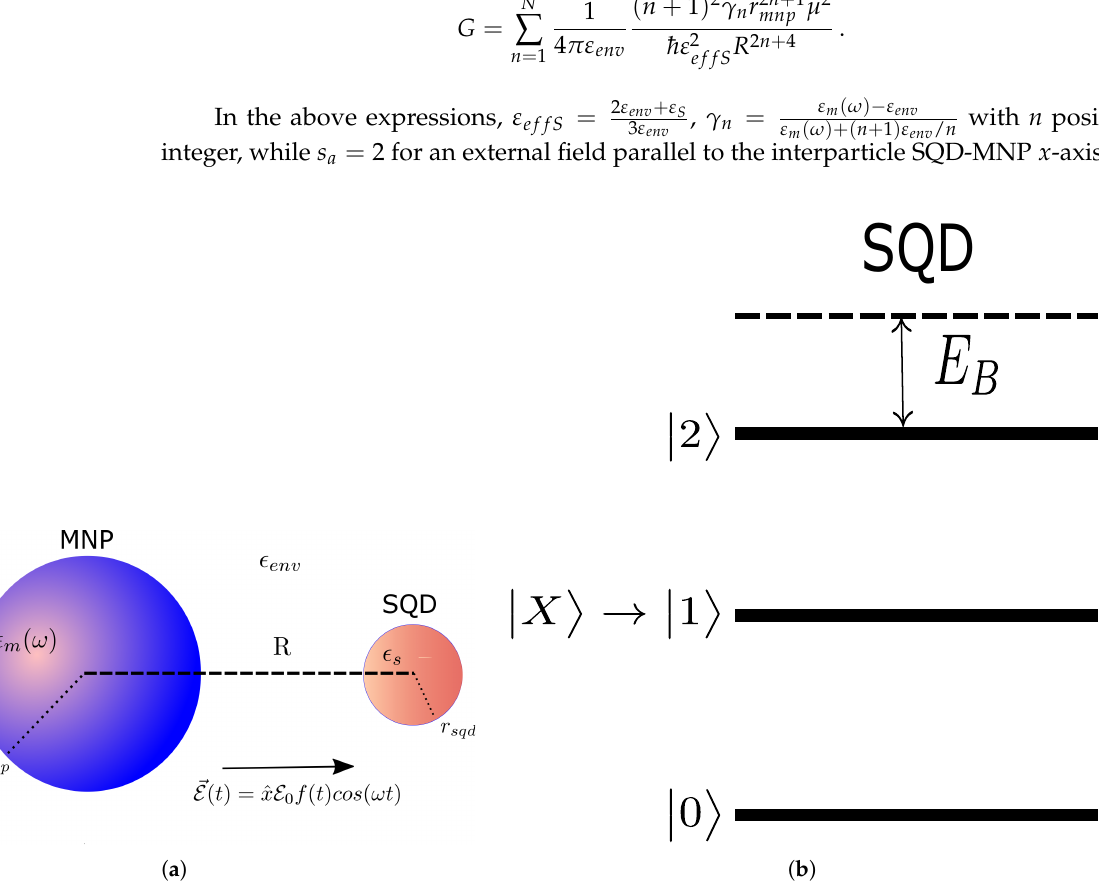
Figure 1. ( a ) Coupled semiconductor quantum dot (SQD)-metal nanoparticle (MNP) nanosystem. ( b ) Energy levels for the biexciton